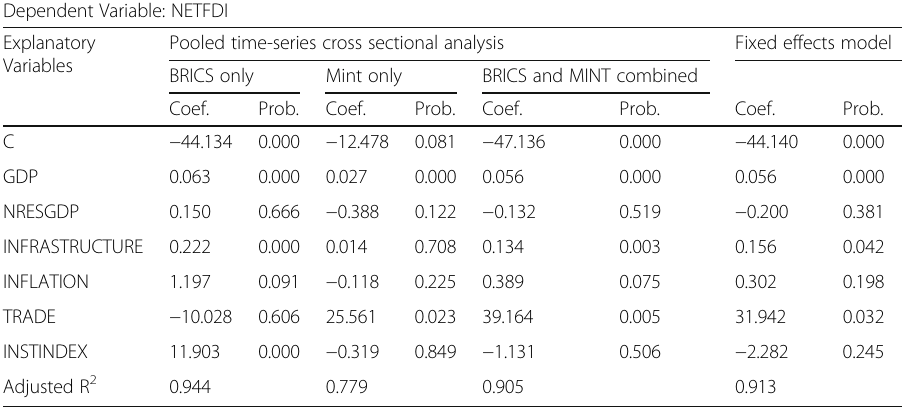
Table 7 Fixed effects model result of panel regression analysis Dependent Variable: